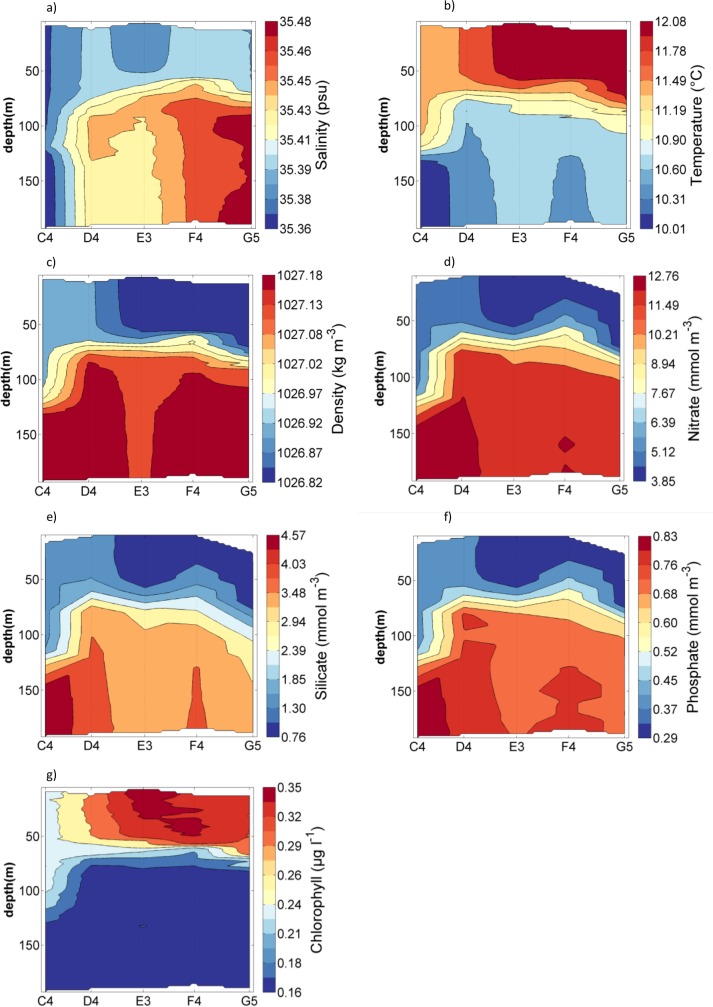
Contour plots for shelf break stations (whole water depth) for a) Salinity, b) Water temperature, c) Density, d) Nitrate, e) Silicate, f) Phosphate and g) Chlorophyll from fluorescence.